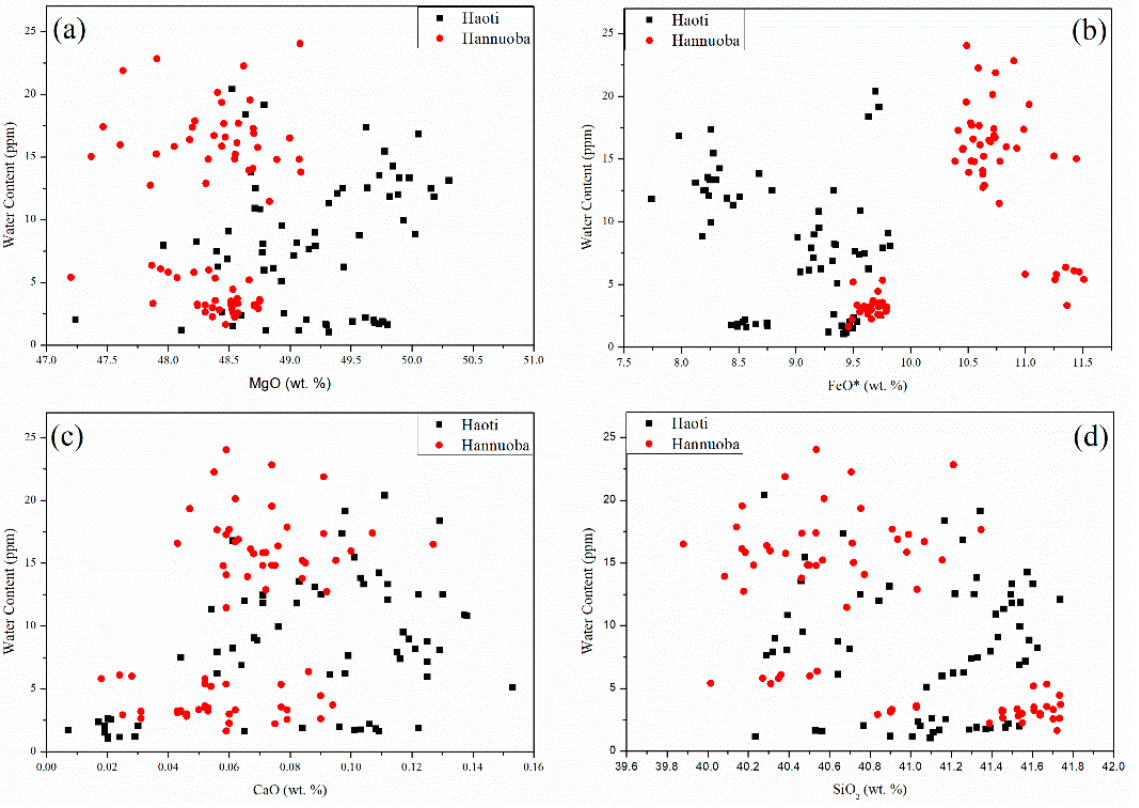
Figure 3. Water content vs. MgO ( a ), FeO ( b ), CaO ( c ), SiO 2 ( d ) of individual spot analyses in olivine from the Hannuoba and Haoti xenoliths.